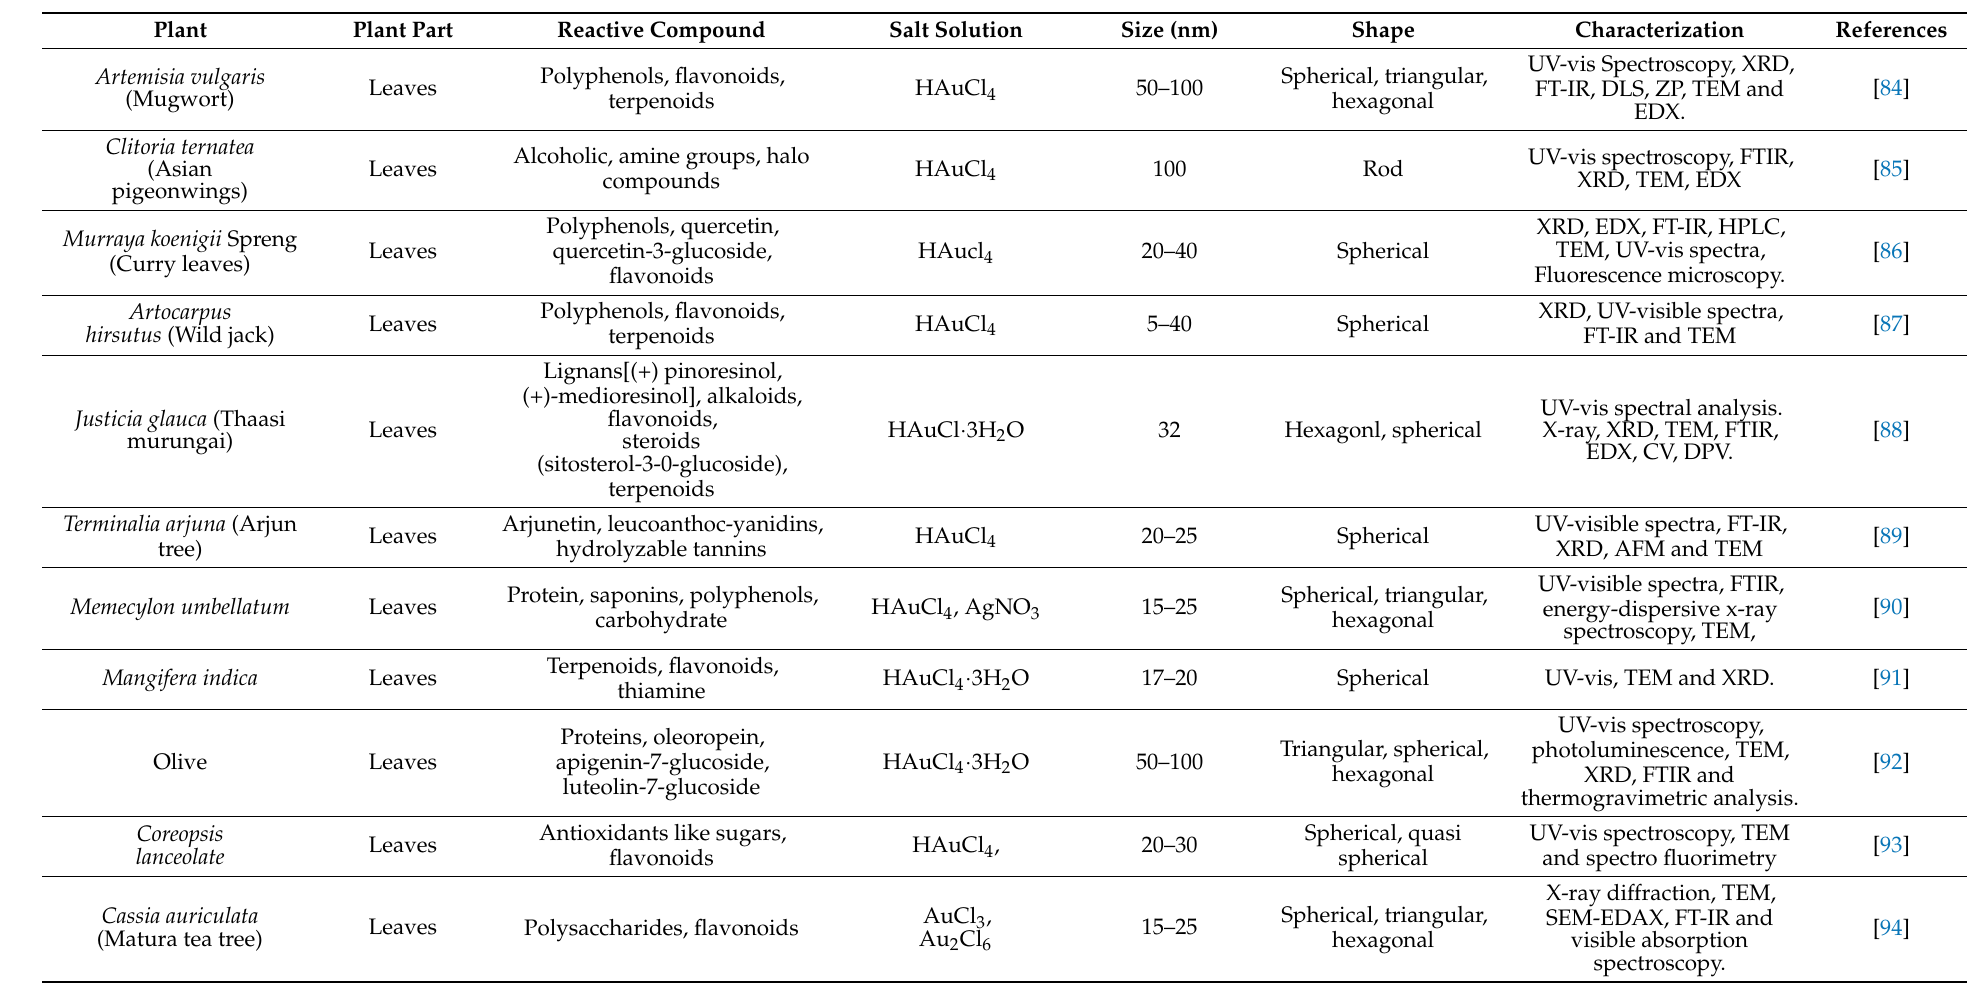
Table 2. Green synthesis of Gold Nanoparticles (AuNPs) from different